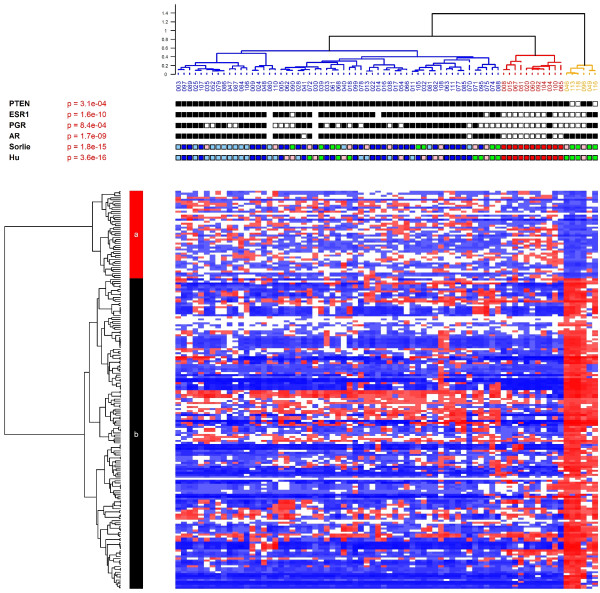
Supervised hierarchical clustering of familial breast cancers. Hierarchical clustering using 200 probe sets that distinguish the orange branch from the other tumors in Figure 1. Table S1 in Additional file 1 lists the corresponding genes. PTEN, ESR1, PGR, AR, Sorlie, Hu: see Figure 1.